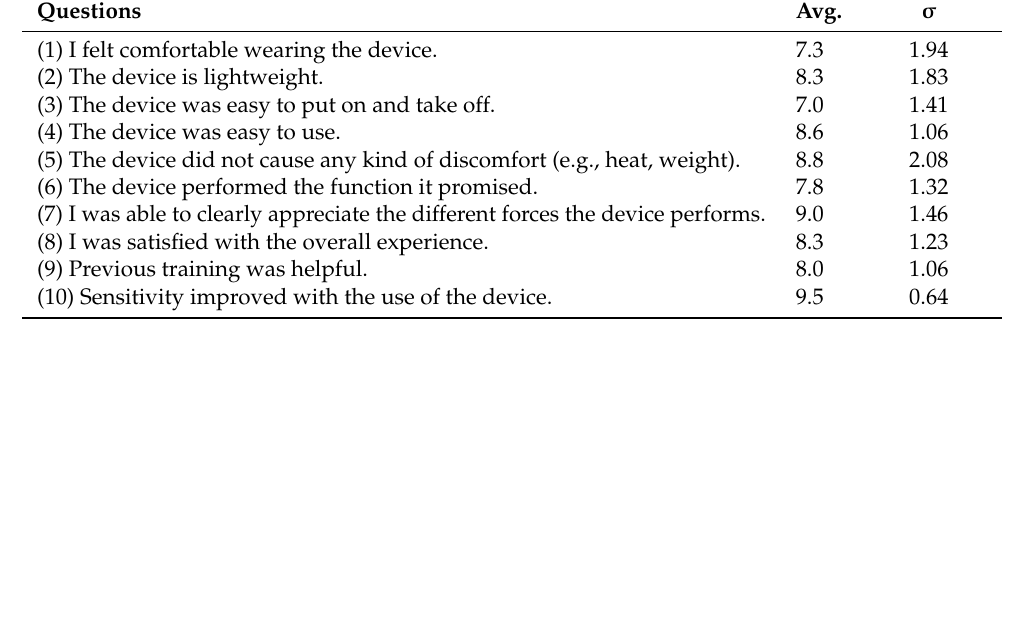
Table 3. Results of questions about general aspects in a scale of 0 to 10 (where 0 = worst, 10 = best).